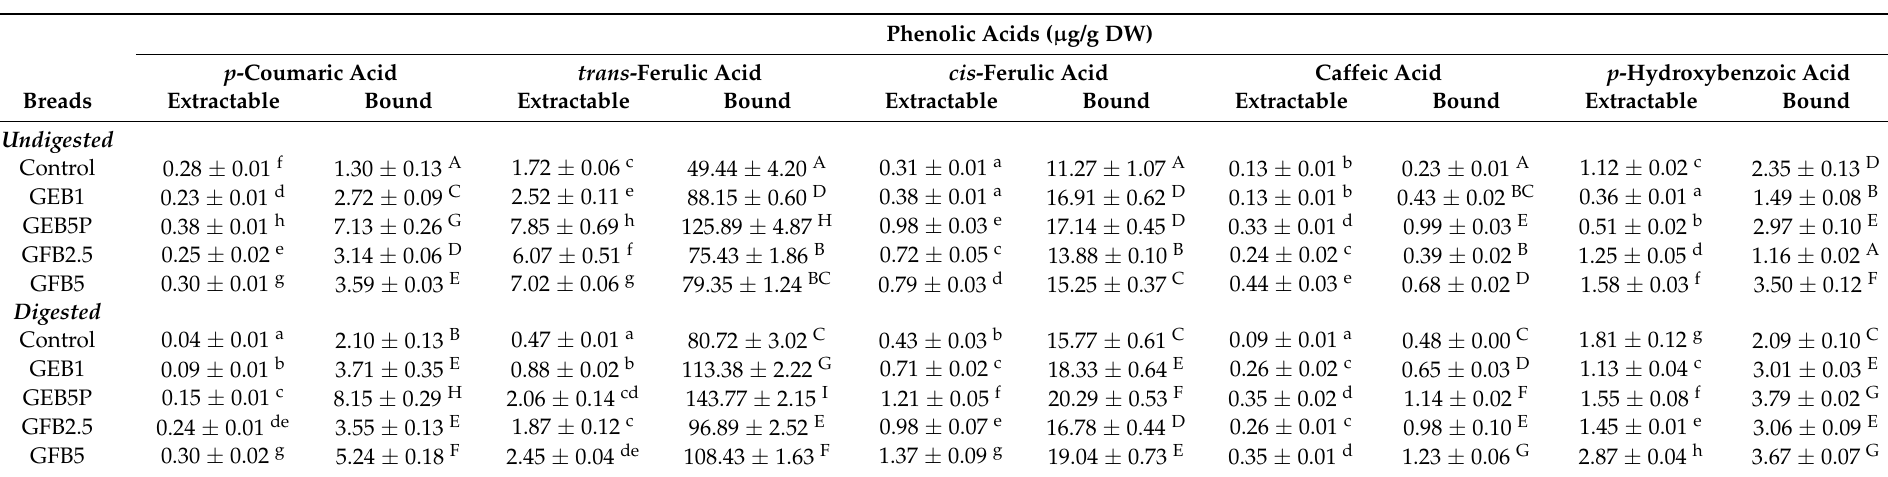
Values are means ± standard deviation. Means followed by different small letters within a column indicate significant differences between the content of extractable phenolic acids ( p < 0.05; Duncan’s multiple range test). Means followed by different capital letters within a column indicate significant differences between the content of bound phenolic acids ( p < 0.05; Duncan’s multiple range test). Control: wheat bread with no added bioprocessed flour; GEB1: wheat bread enriched with 1% “germinated + enzymatic treated” spelt flour; GEB5P: wheat bread enriched with 5% pasteurized “germinated + enzymatic treated” spelt flour; GFB2.5: wheat bread enriched with 2.5% “germinated + fermented” spelt flour; GFB5: wheat bread enriched with 5% “germinated + fermented” spelt